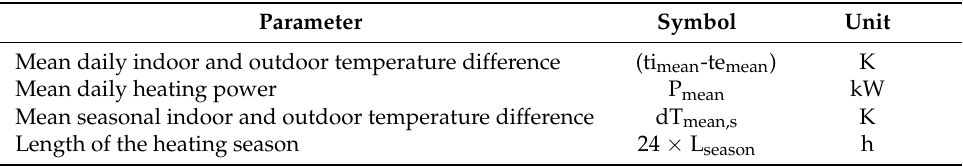
Table 2. Parameters used in the regression